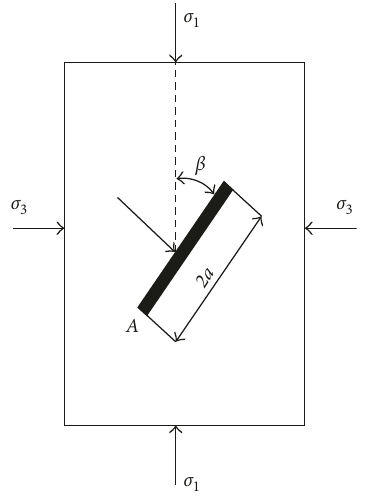
Figure 1: Single-crack force model under triaxial